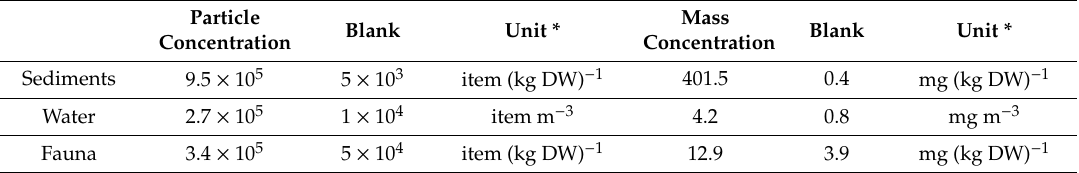
Table 1. MP mass and MP particle number concentrations in the stormwater retention pond. Particle mass and number concentrations are not corrected for blank